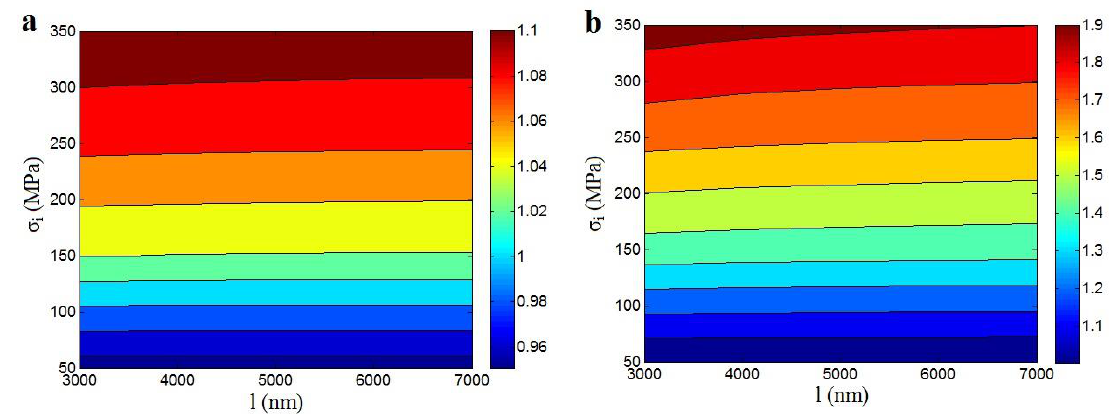
Figure 5. The predictions of Pukanszky model at di ff erent levels of “ l ” and “ σ i ” factors at σ m = 40 MPa, φ f = 0.02, R = 10 nm and ( a ) t = 5 nm and ( b ) t = 15 nm.